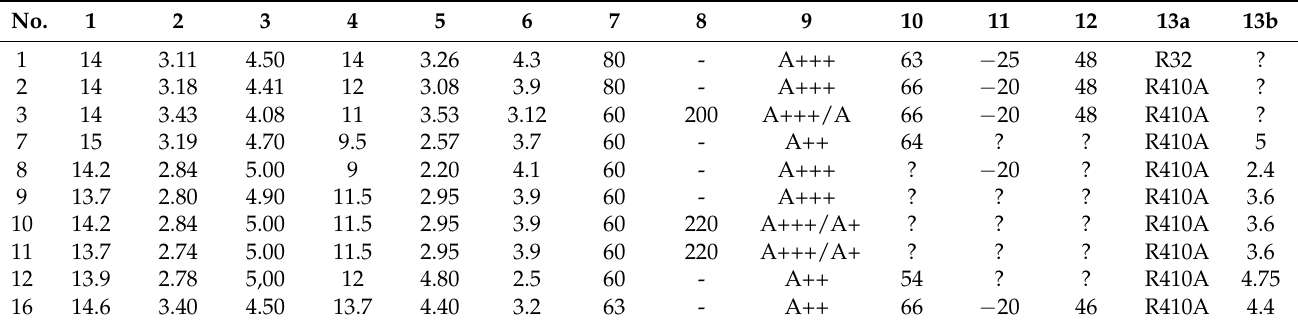
Table A2. Substantial and auxiliary attributes of considered ASHP